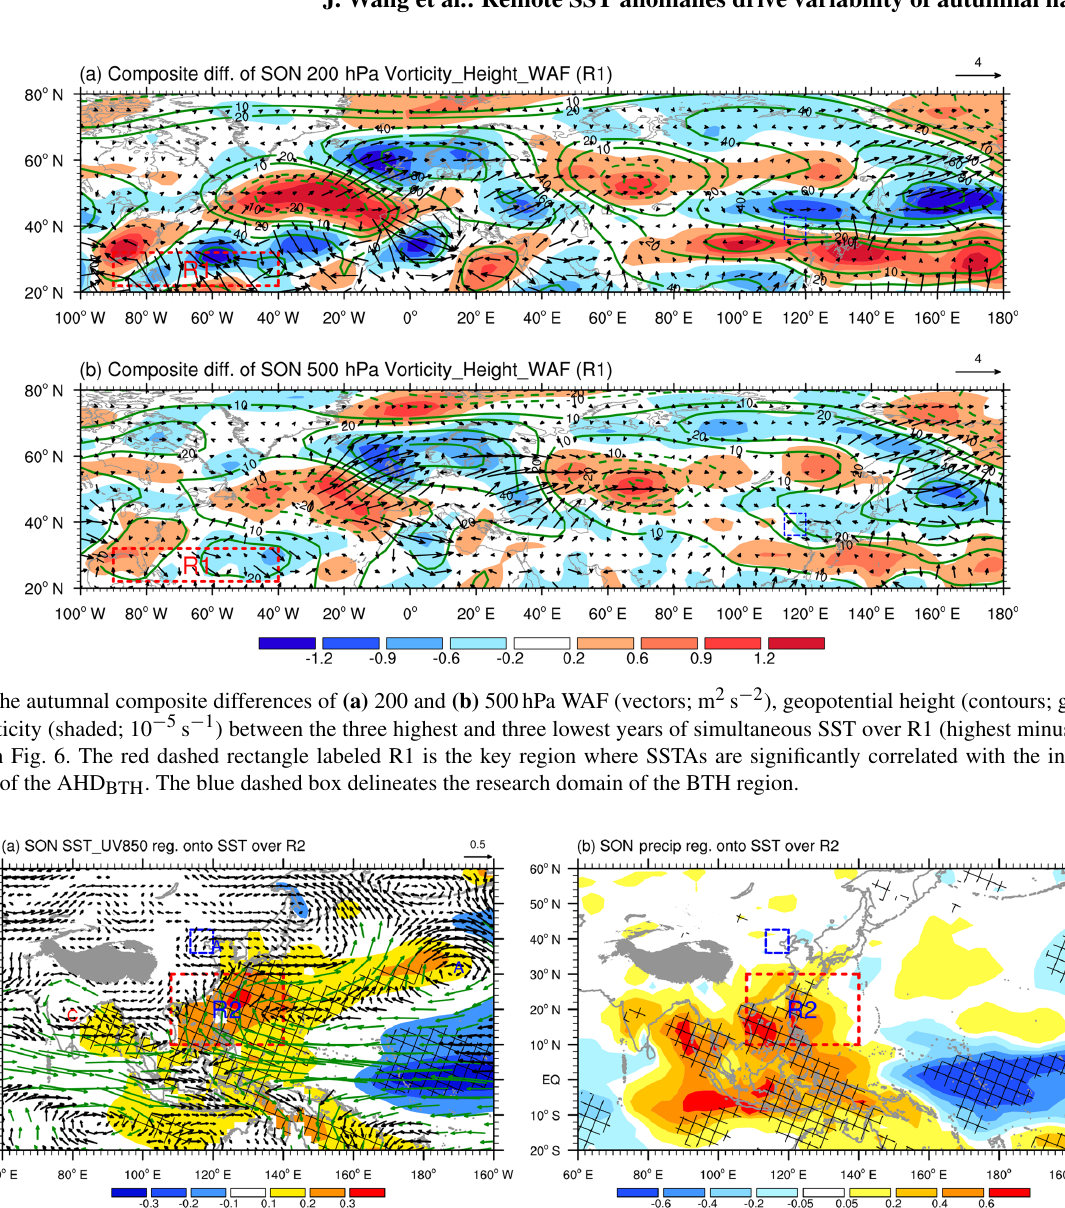
Figure 9. Regressed anomalies of autumnal (a) UV850 (vectors; ms − 1 ) and SST (shaded; ◦ C) and (b) precipitation (shaded; mmday − 1 ) with respect to the simultaneous interannual component of the SST over R2. In panel (a) , green arrows represent the wind vectors with statistical significance above the 99% confidence level, and vectors with scales less than 0.05ms − 1 are omitted. Regression coefficients that are significant at the 99% confidence level are crosshatched. The dashed red rectangle labeled R2 is the key region where SSTAs are significantly correlated with the interannual component of the AHD BTH . The blue dashed box delineates the research domain of the BTH region. The gray shaded area denotes the Tibetan Plateau. The letter A (C) represents the center of the anticyclonic (cyclonic)